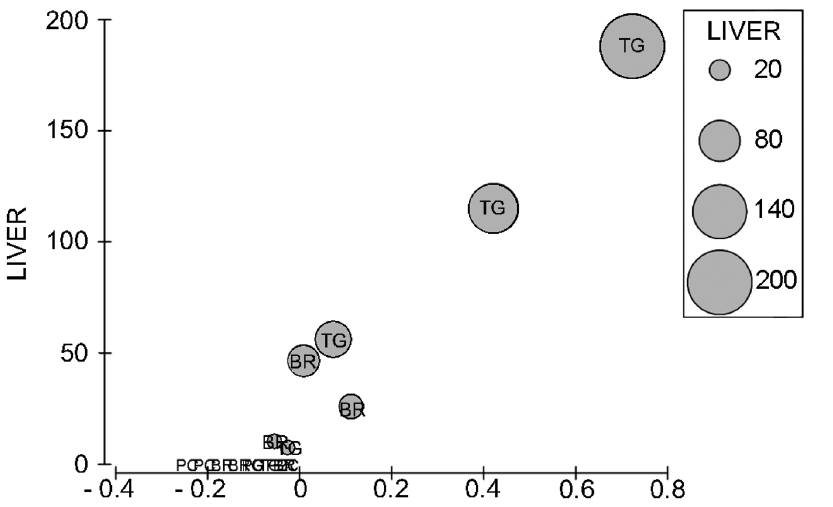
Figure 4. Canonical analysis of principal coordinates discriminating biochemical responses along caulerpin concentration gradient. CAP was based on the Euclidean distance matrix of the subset multivariate data. Caulerpin concentration in fish liver was represented with grey circles of increasing size superimposed on each specimen.